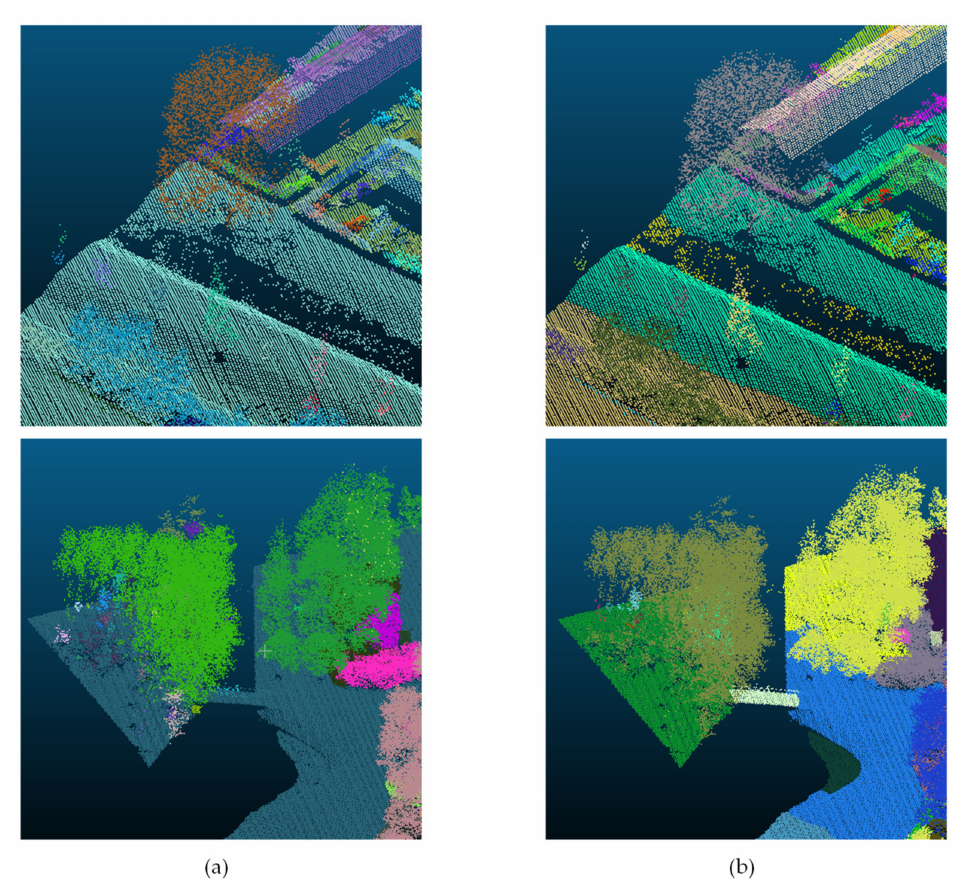
Figure 5. ( a ) Segmentation without intensity; ( b ) Segmentation with